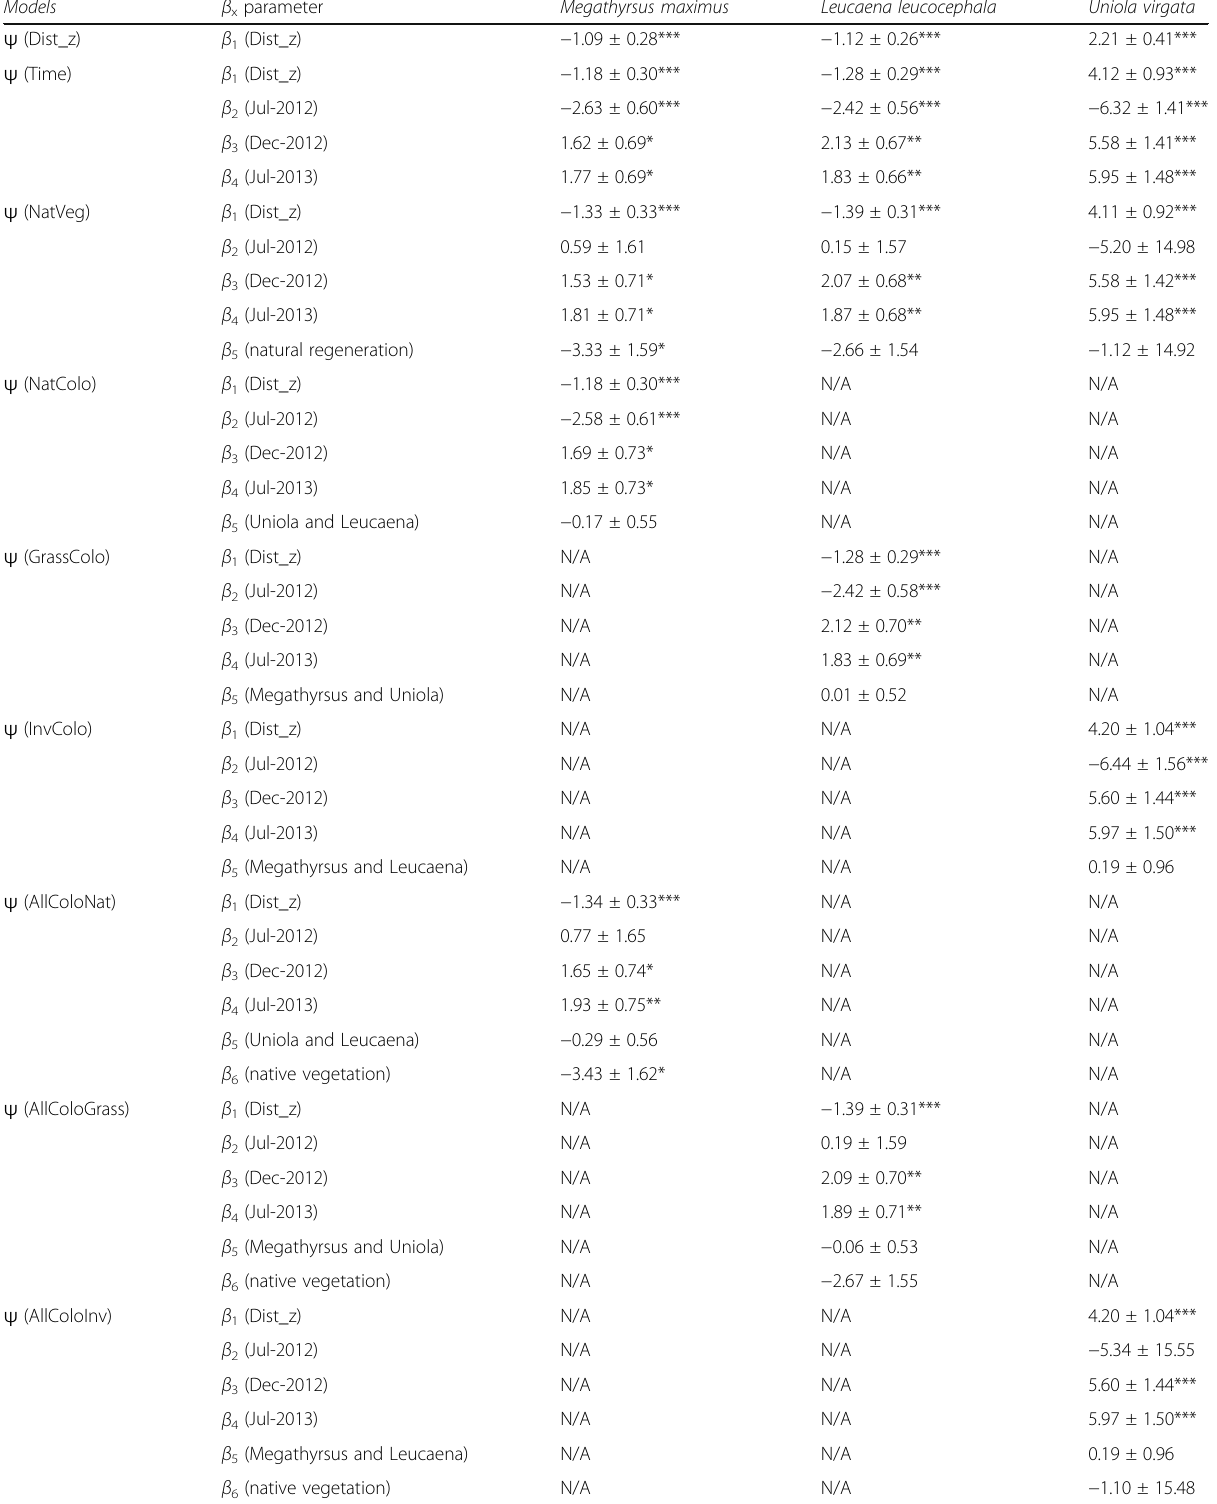
Table 3 Significant model parameter results for M . maximus , L . leucocephala , and U . virgata probability of occurrence ( ѱ ) derived from cross-transect surveys conducted along the 570-m bulldozed trail in the Ensenada section of Guánica Forest